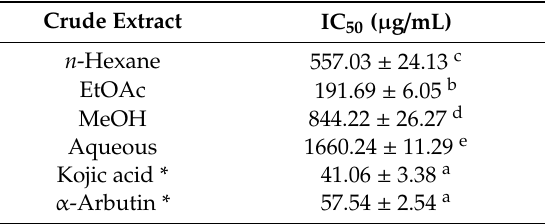
Table 1. Tyrosinase inhibitory activity of crude extracts of M. zapota bark.